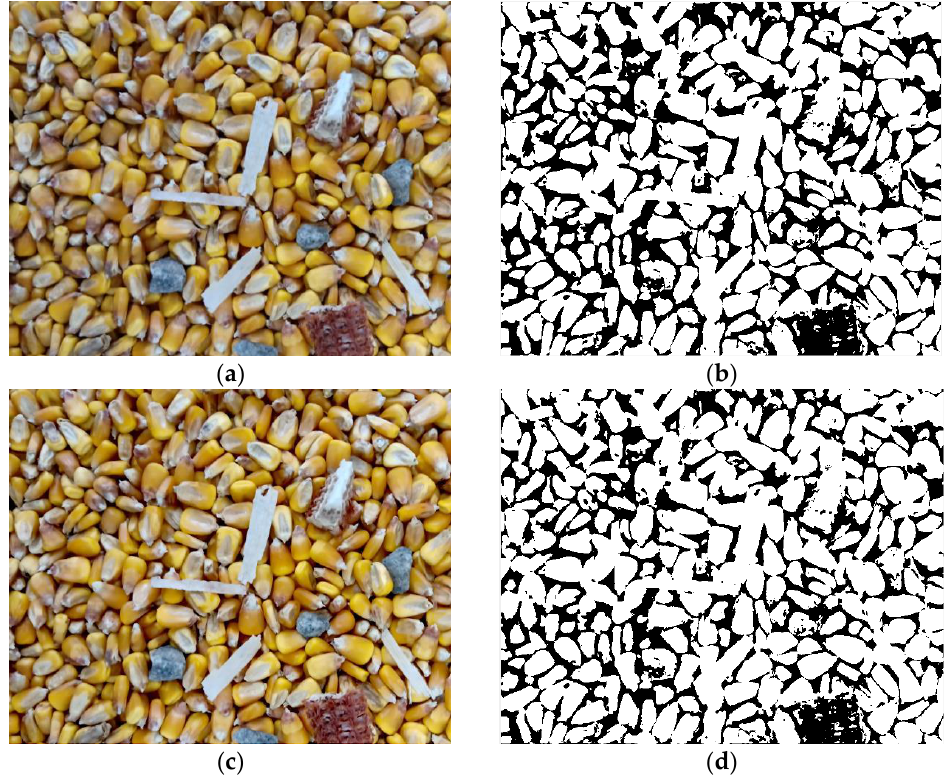
Figure 6. Image pre-processing results. ( a ) Original image, ( b ) Binary image of original image, ( c ) Image enhancement using MSRCR, ( d ) Binary image of enhanced image.